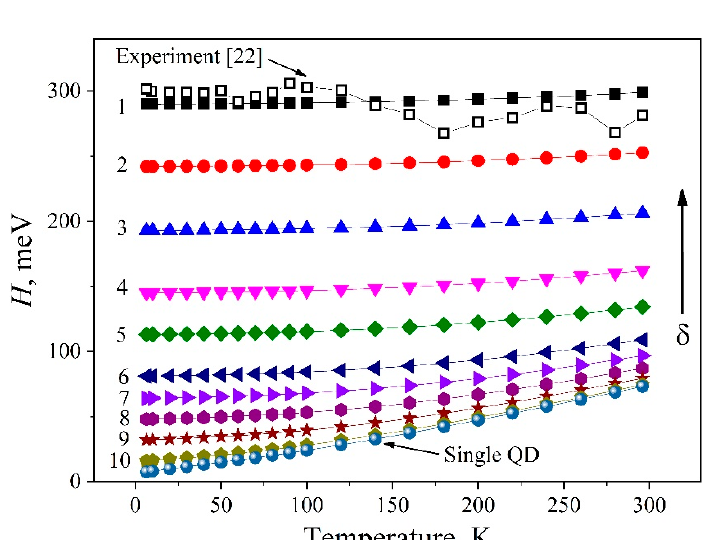
Figure 8. Simulated H ( T ) dependencies of the exciton band of QD ensembles with different size distributions (Table 2). Open squares denote the experimental dependence for the QD-1 [22].